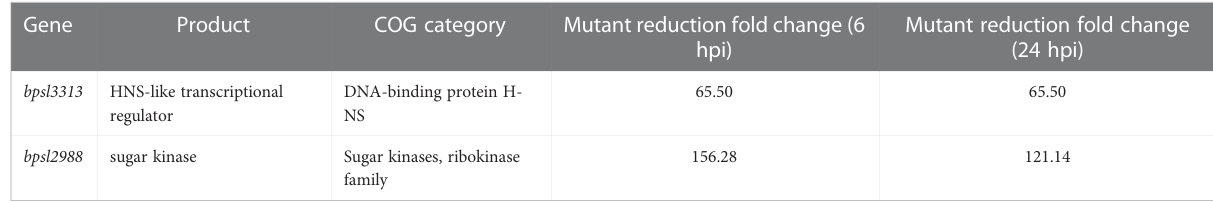
TABLE 3 B. pseudomallei genes selected for validation.